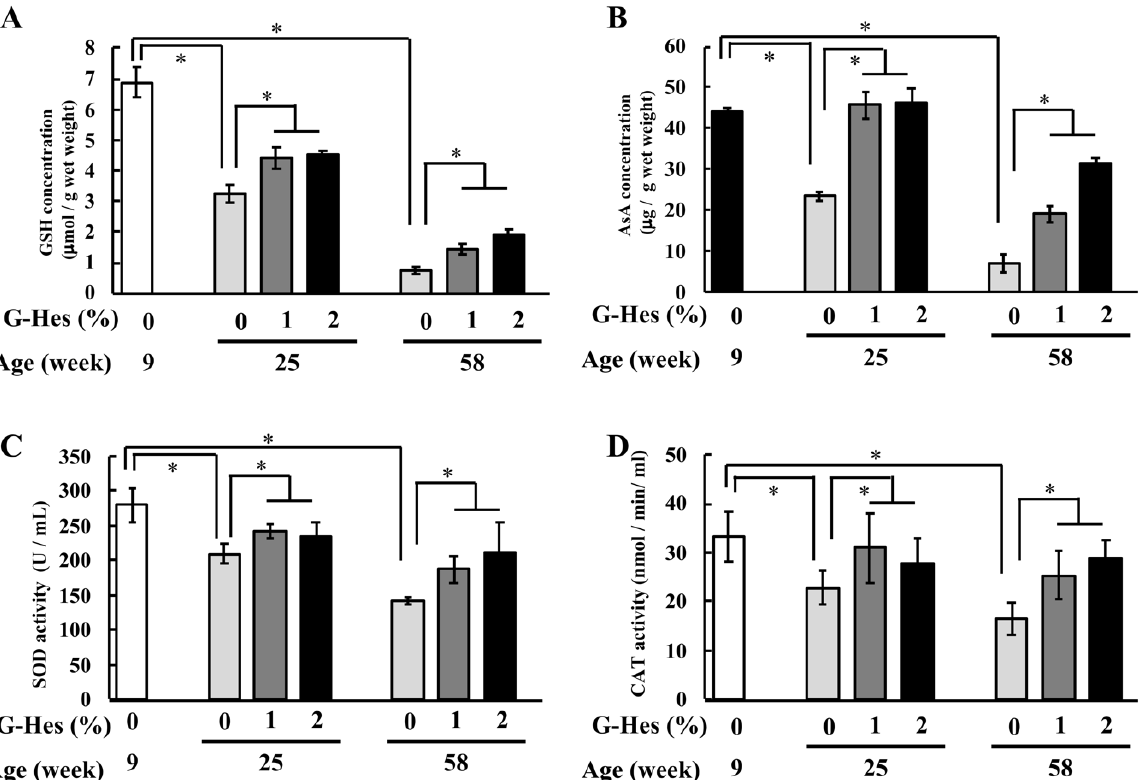
Figure 3. Effect of G-Hsd consumption on the lens and plasma antioxidant levels. Antioxidant levels in the lens and plasma were measured for short-term exposure (ST) and long-term exposure (LT) groups with water, 1% G-Hsd, or 2% G-Hsd. ( A ) Glutathione (GSH) levels and ( B ) AsA levels in the lens were measured ( n = 4–5). ( C ) SOD activity in the plasma was measured using a Superoxide Dismtase (SOD) assay kit, and ( D ) Catalase (CAT) activity in the plasma was measured using a CAT assay kit ( n = 6 mice per group). The experiments used three to five independent samples per group. Data are presented as the mean ± SEM. * indicates a significant difference compared to the control group ( p < 0.05).